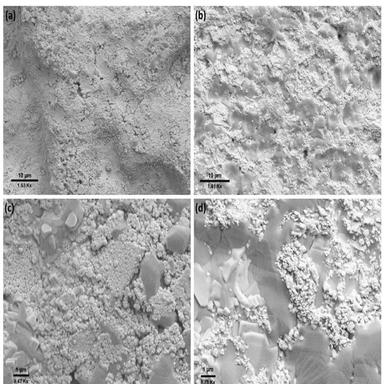
SEM images of the (a,c) inkjet-printed and (b,d) drop-cast symmetrical cells in low and high magnifications, respectively.